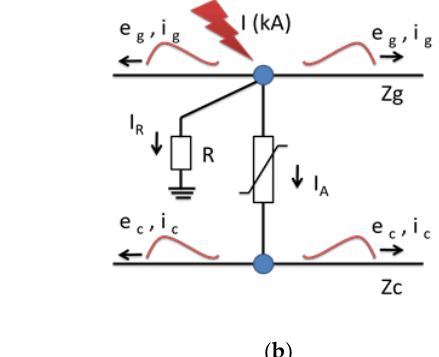
(C.1) Strike to the Phase Conductor The simple arrester discharge energy equation is expressed by [38].